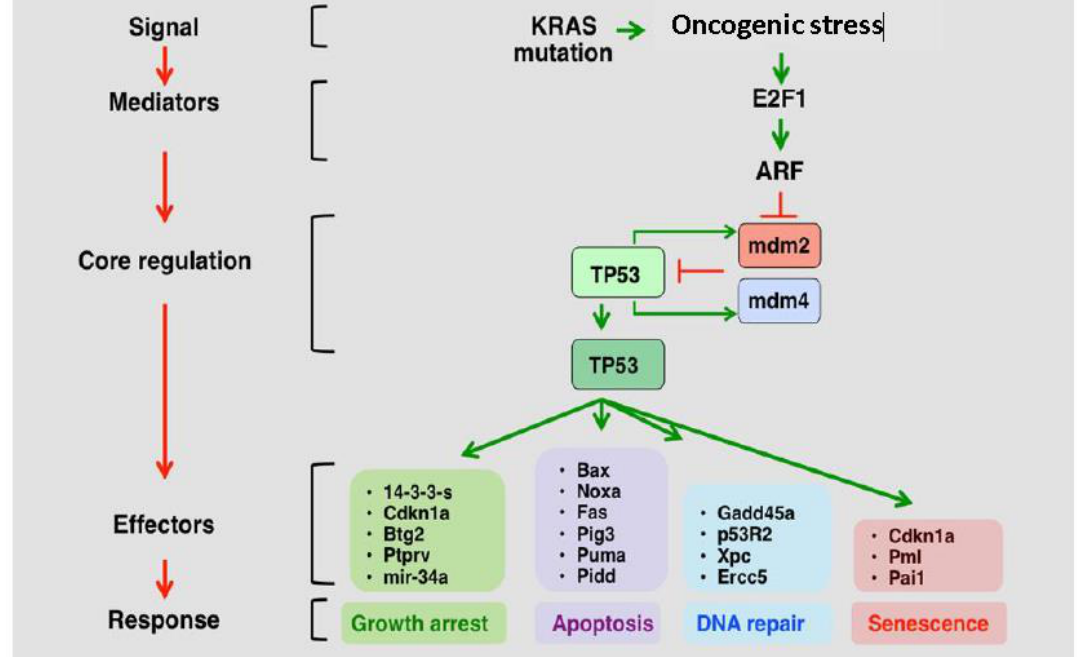
Figure 2. The p53-ARF-MDM2/4 pathway (adapted from the p53 website) [24]. In response to hyperproliferative stress and/or DNA damage, pathway mediators, such as ARF, are activated. MDM2 and MDM4 mark p53 for degradation, and are subsequently degraded when upstream mediators are activated. This releases p53 from degradation, and leads to increased cell cycle arrest, apoptosis, DNA Repair, and cellular senescence.